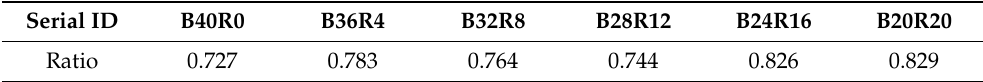
Table 5. Ratio of 7 d UCS to 28 d UCS.